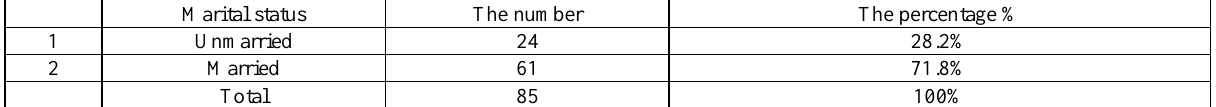
Table 4. Distribution of members of the study sample according to the social status